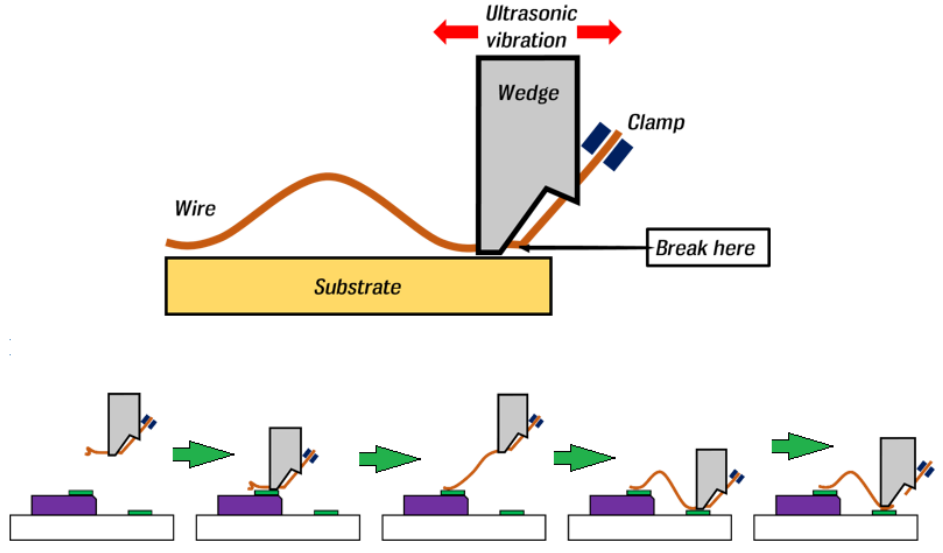
Figure 11. Wedge bonding process in wire bonding.